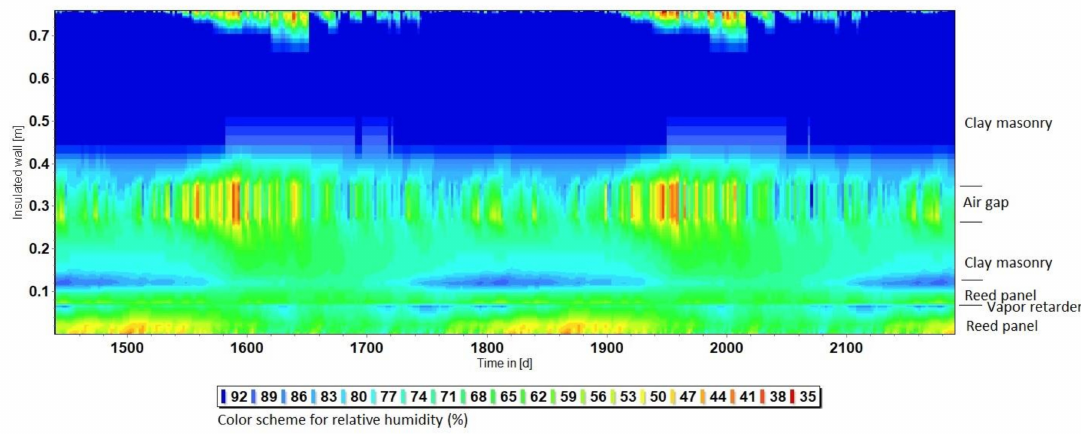
Figure 9. Relativehumidityvaluesinmodeledinterior-insulatedwallwithvaporretarder. Reproducedwith permission from